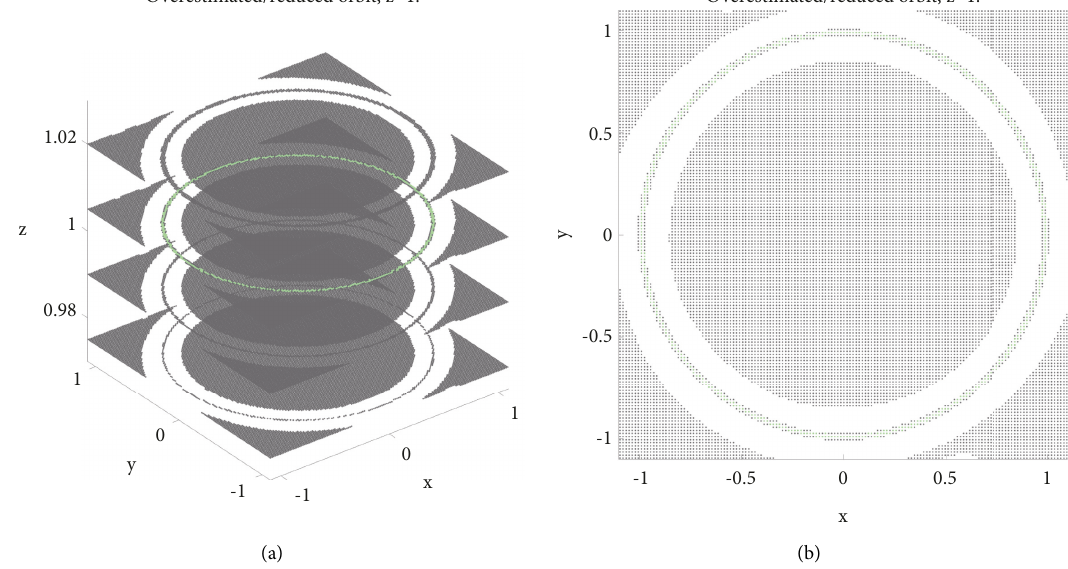
v, 14 is plotted in black. The green points represent the